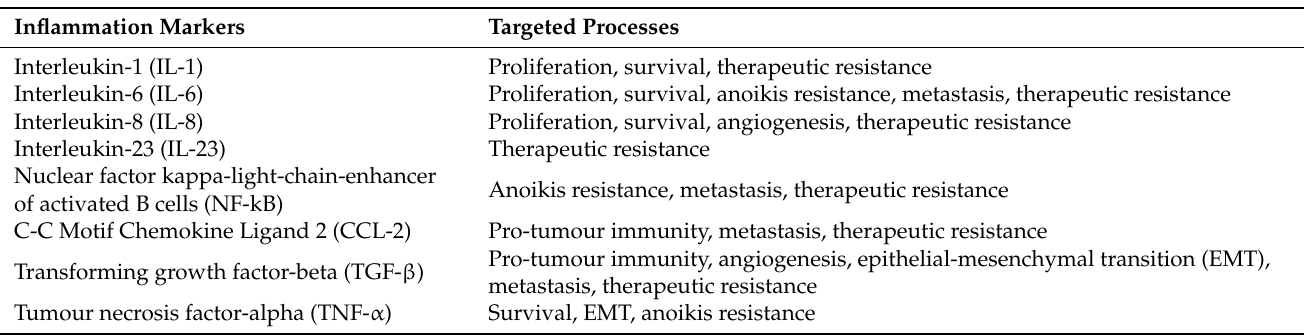
Table 1. Inflammation markers and their targeted processes in cancer (adapted from Archer M. et al. [149]). Inflammation Markers Targeted